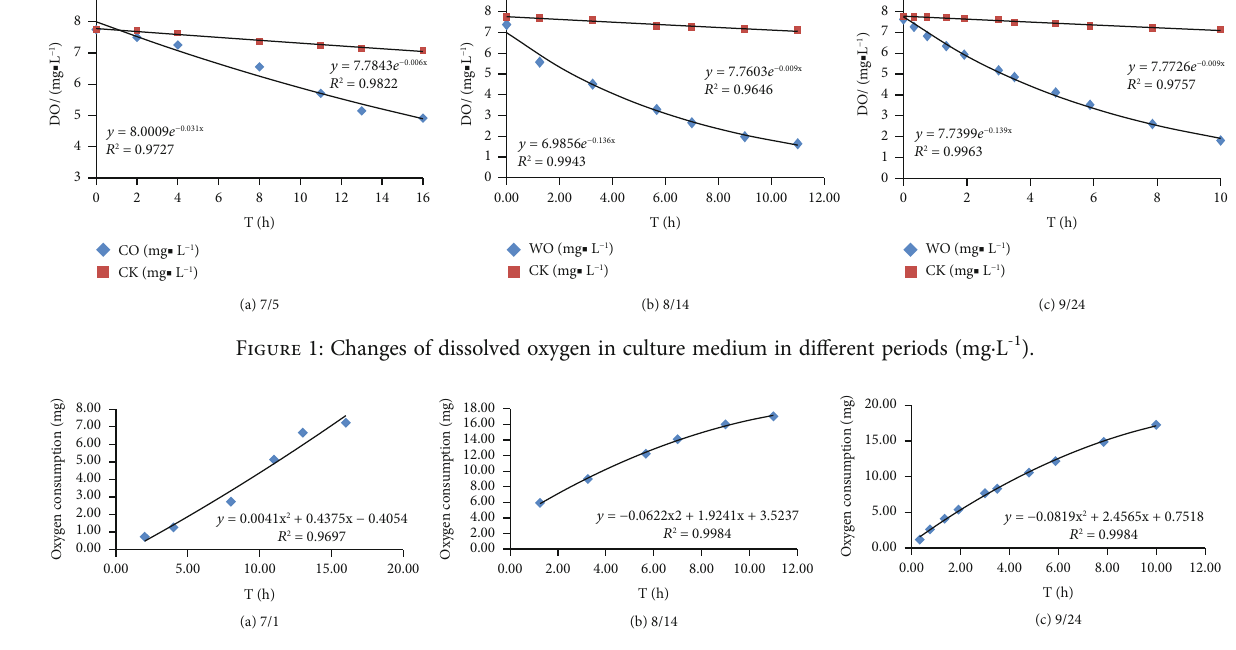
Figure 2: Oxygen consumption per cotton plant in di ff erent periods